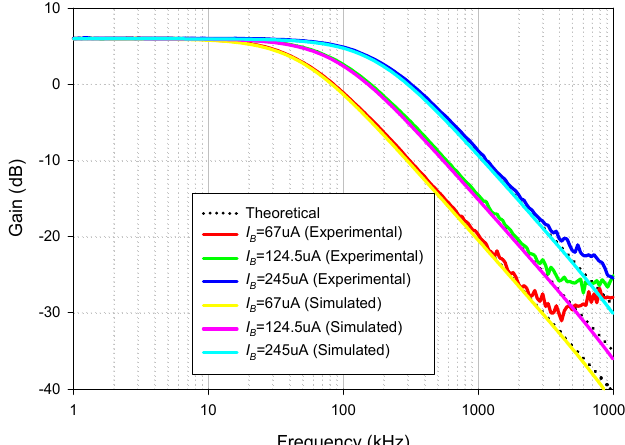
Figure 13. Frequency gain response of LP with different I B values.